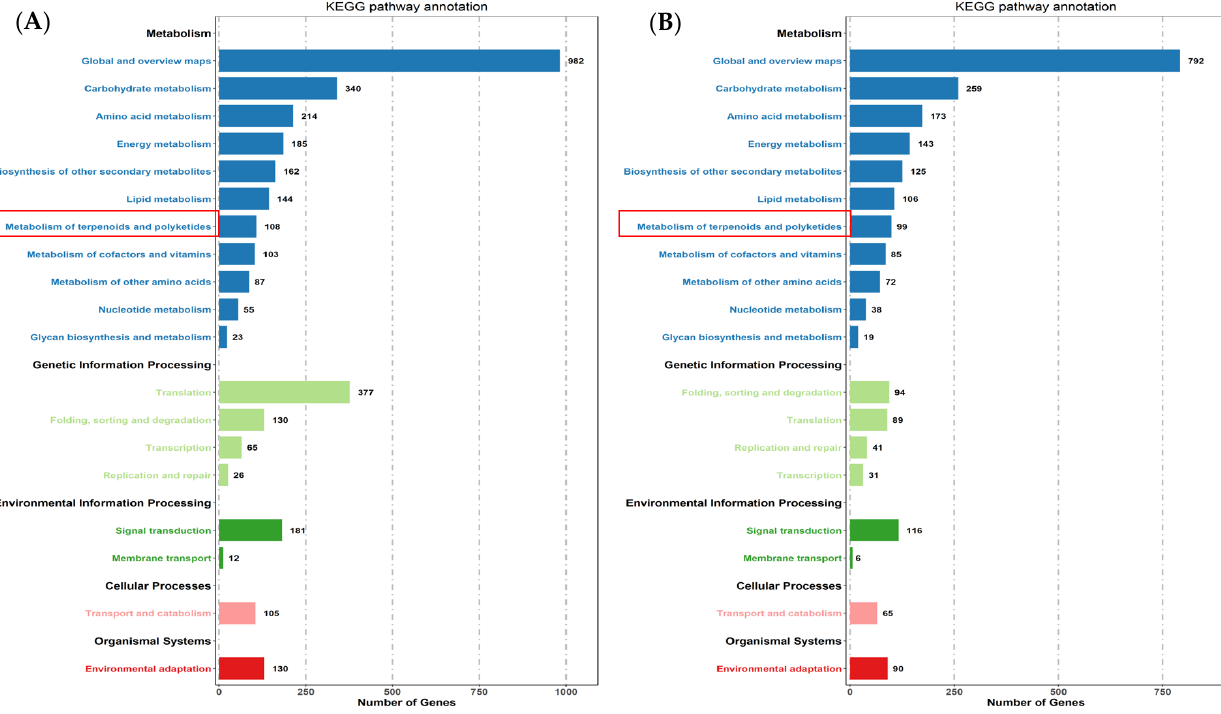
Figure 4. KEGG pathway enrichment of DEGs after controlled light vs. 24 h darkness treatment ( A ) and controlled darkness vs. 24 h light exposure ( B ) in M. canadensis leaves’ transcriptomes.